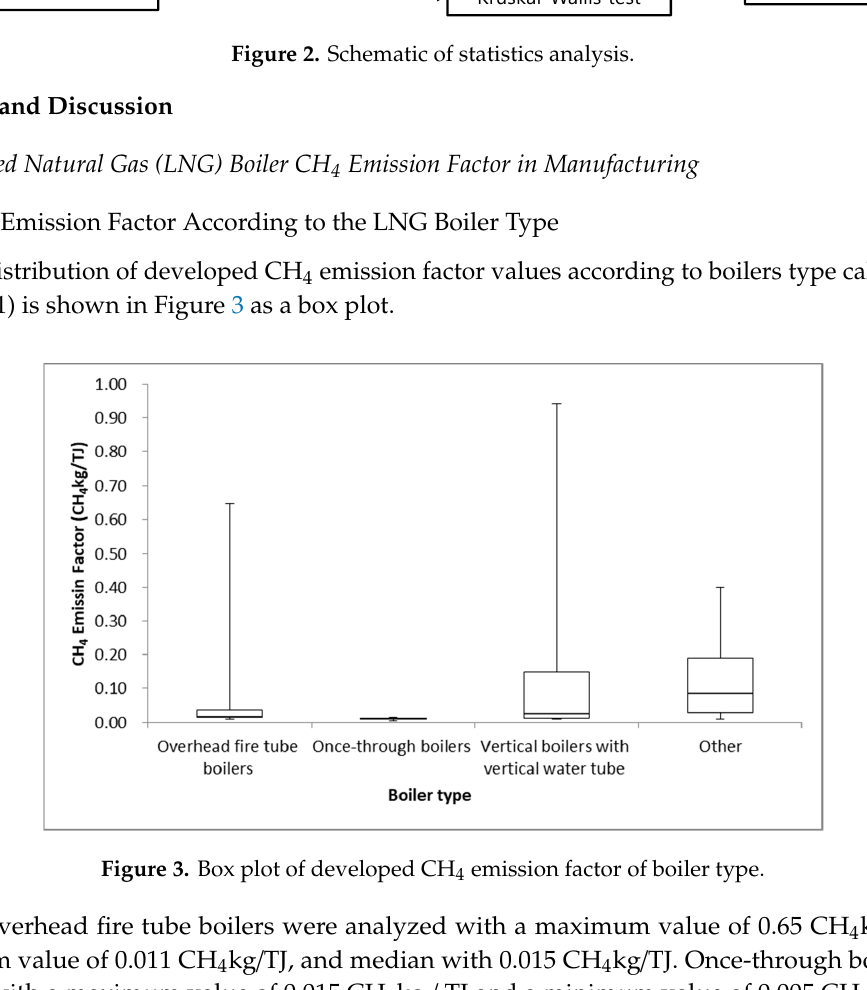
Table 4. CH 4 emission factor of LNG boiler type .